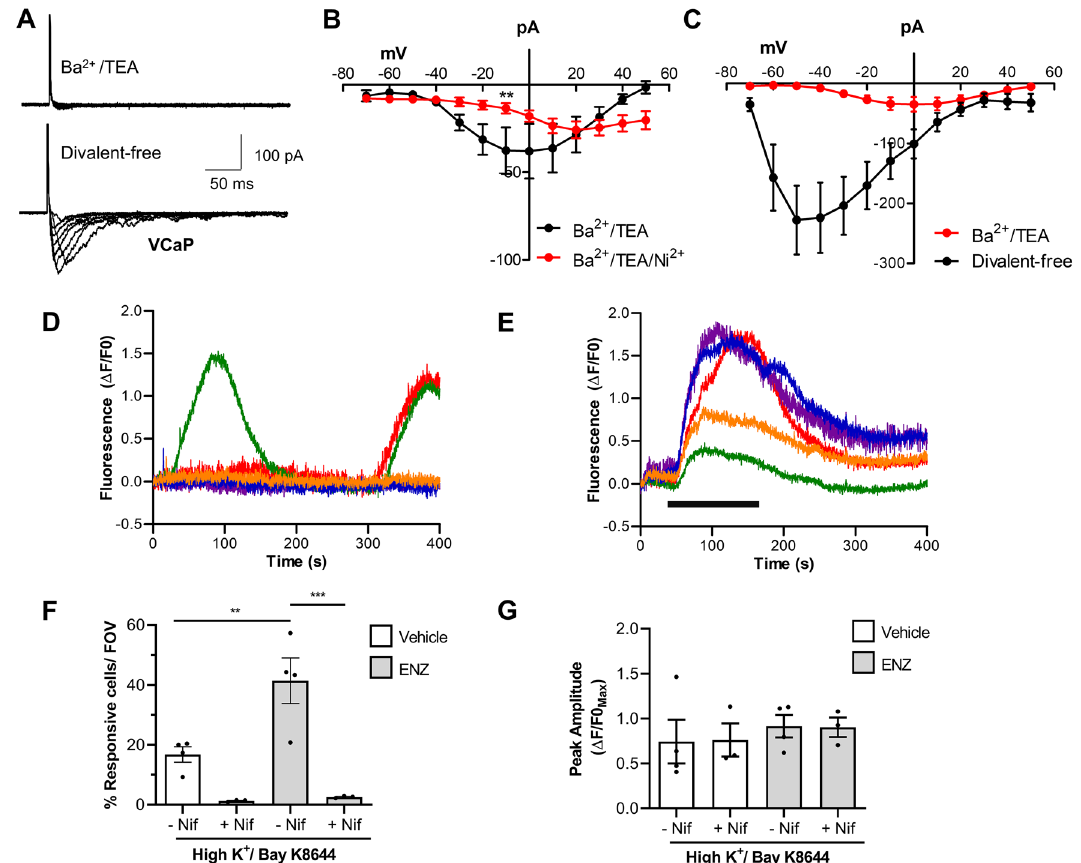
Figure 7. Ca V -mediated Ca 2+ signalling in T2E + VCaP. ( A ) Representative currents from VCaP in Ba 2+ / TEA Hanks and in divalent-free solution. ( B ) A portion of the inward current was Ni 2+ -sensitive; the residual current–voltage plot was right-shifted by 20 mV (n = 7 cells, N = 5 cultures). ( C ) Summary current–voltage plot for VCaP currents (n = 9 cells, N = 7 cultures) recorded in Ba 2+/ TEA Hanks and in divalent-free solution. ( D ) Representative recordings from 5 VCaP perfused with Hanks. Oscillating cells (green and red) were typical of 2.9 ± 1.2% (mean ± SEM) VCaP within each field of view (N = 5 recordings). ( E ) VCaP were challenged with high K + /Bay K 8644 (10 µM) as indicated with a horizontal bar, and Ca 2+ transients could frequently be recorded. Five ROI are plotted on a fluorescence-time graph (typical of N = 3 recordings). ( F ) ENZ significantly increased the percentage of high K + /Bay K 8644-responsive VCaP per recording compared with vehicle controls (1-way ANOVA with Šídák’s multiple comparison test, p < 0.01 (**) or p < 0.001 (***), N = 4). ( G ) The average amplitude (ΔF/F0) of high K + /Bay K 8644-induced Ca 2+ events were similar in the absence and presence of ENZ or